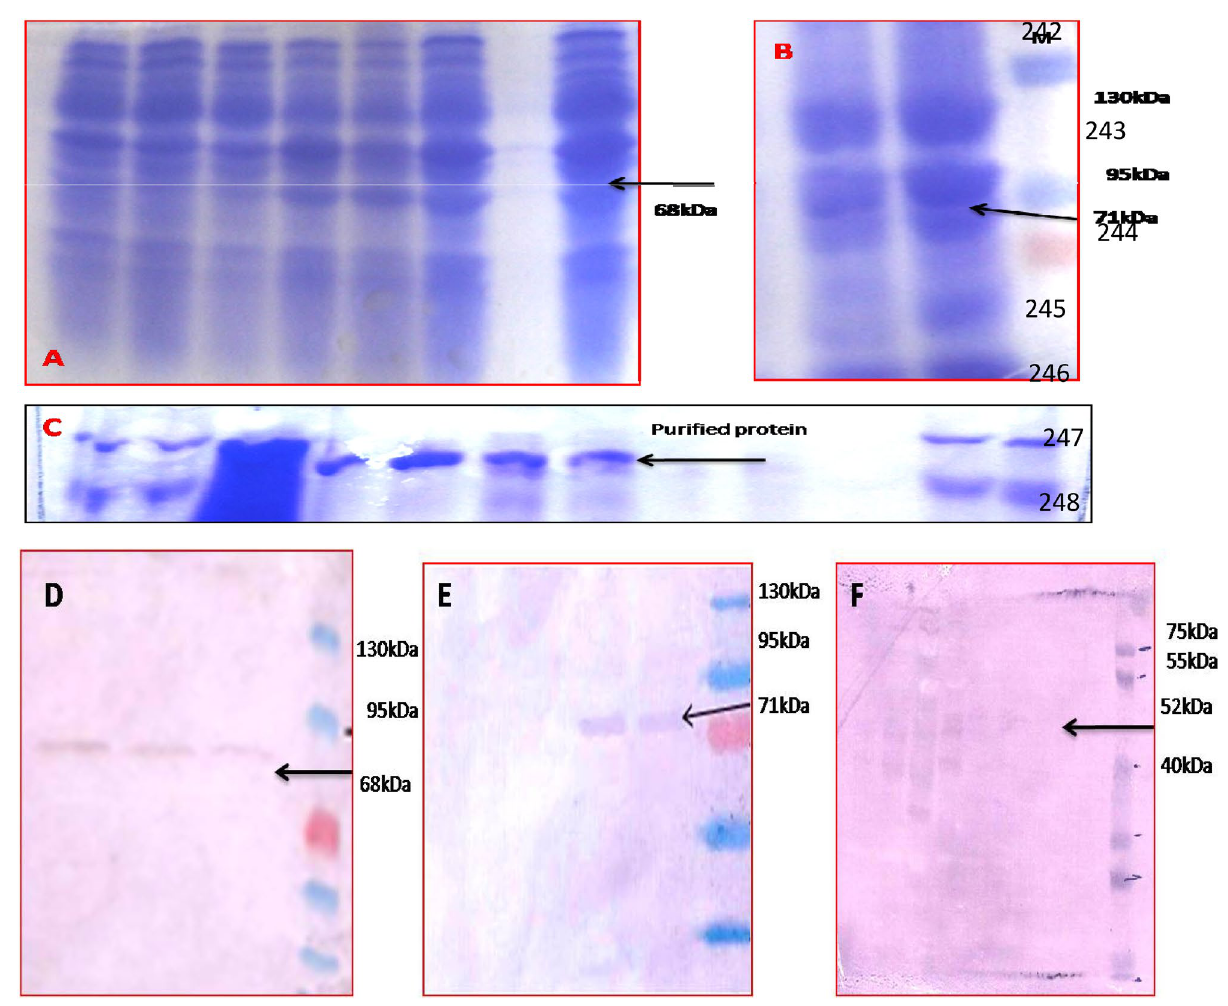
Figure 1. Protein expressions analyzed through SDS-PAGE and confirmed by Western Blot analysis. ( A , B ) SDS-PAGE of induced crude (1 mM-IPTG) proteins of CEMB- Cry 1Ac, CEMB- Cry 2A and CEMB-GTGene genes. ( C ) Purified proteins for Western Blot analysis. ( D ) Western Blot Analysis for CEMB- Cry 1Ac protein, Lanes 1–3: CEMB- Cry 1Ac protein (68 kDa), Lane M. Pre-strained protein ladder (Fermentas). ( E ) Western